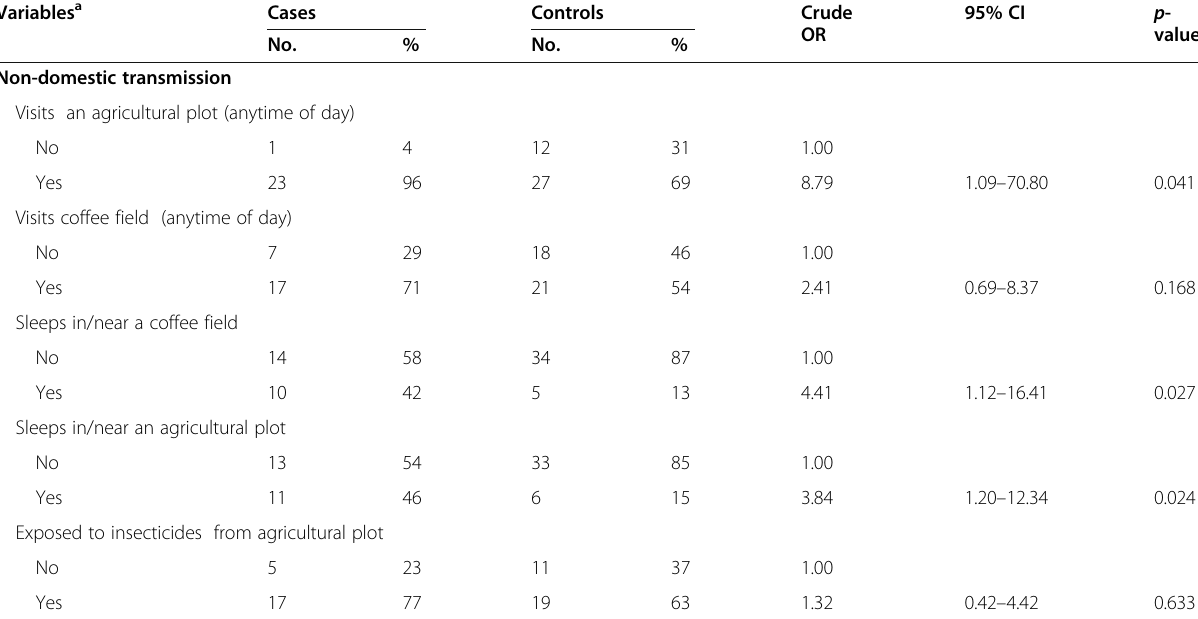
Table 1 Crude odds ratios (OR) and their 95% confidence intervals (95% CI) for the association between Leishmania spp. infection for variables associated with intradomestic, peridomestic, and non-domestic CL transmission, Alto Mayo, Peru 2014 – 2016 (Continued) Variables